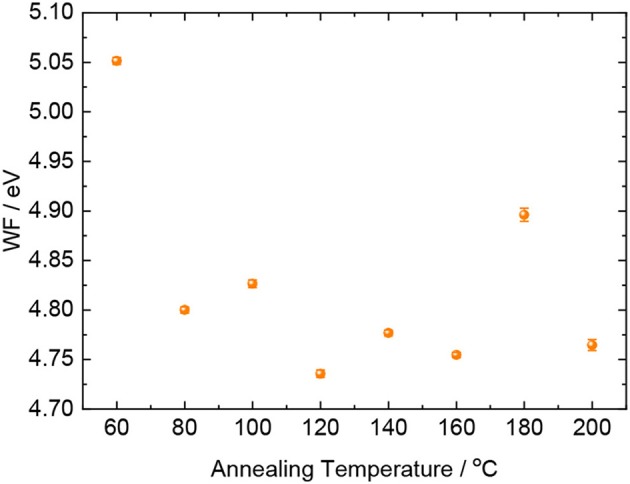
Effect of annealing temperature on the WF of the surface of MoO3 thin films deposited on ITO-coated glass slides.